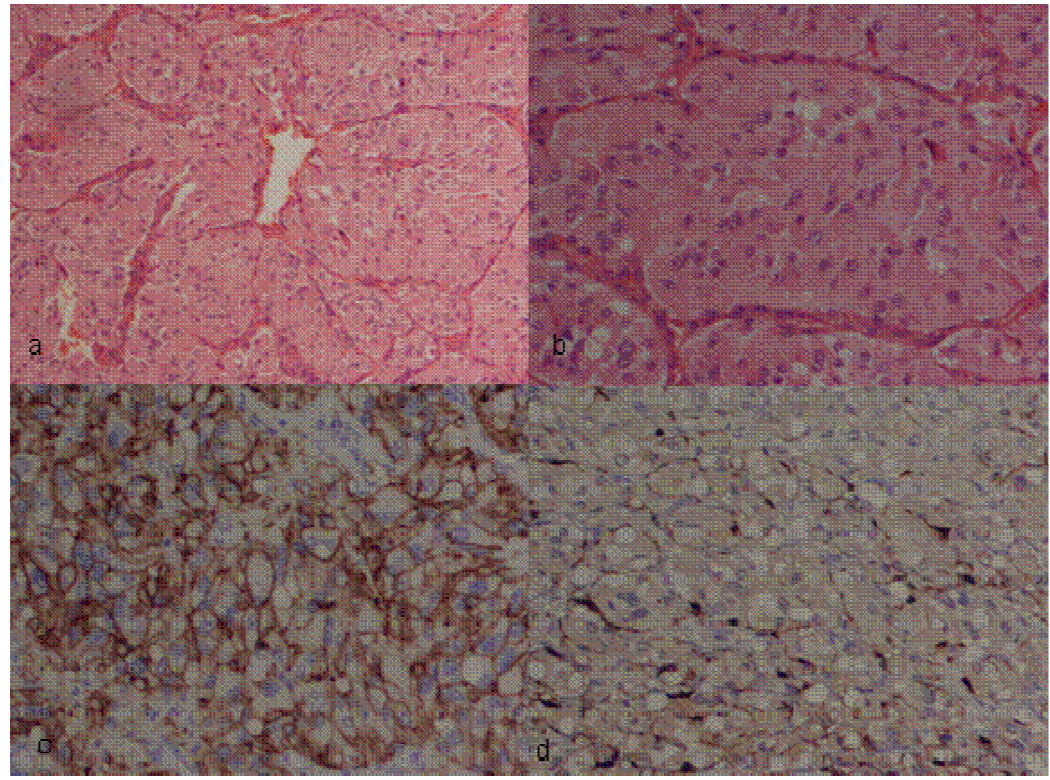
FIGURE 2 . (a) A low-power view of the mass showing nested architecture and prominent vascularity (H&E, × 100 magnification). (b) Cells show moderate nuclear pleomorphism and abundant granular eosinophilic cytoplasm (H&E, × 200 magnification). (c) Strong CD56 membrane positivity ( × 100 magnification). (d) Scattered S100-positive sustentacular cells ( × 100